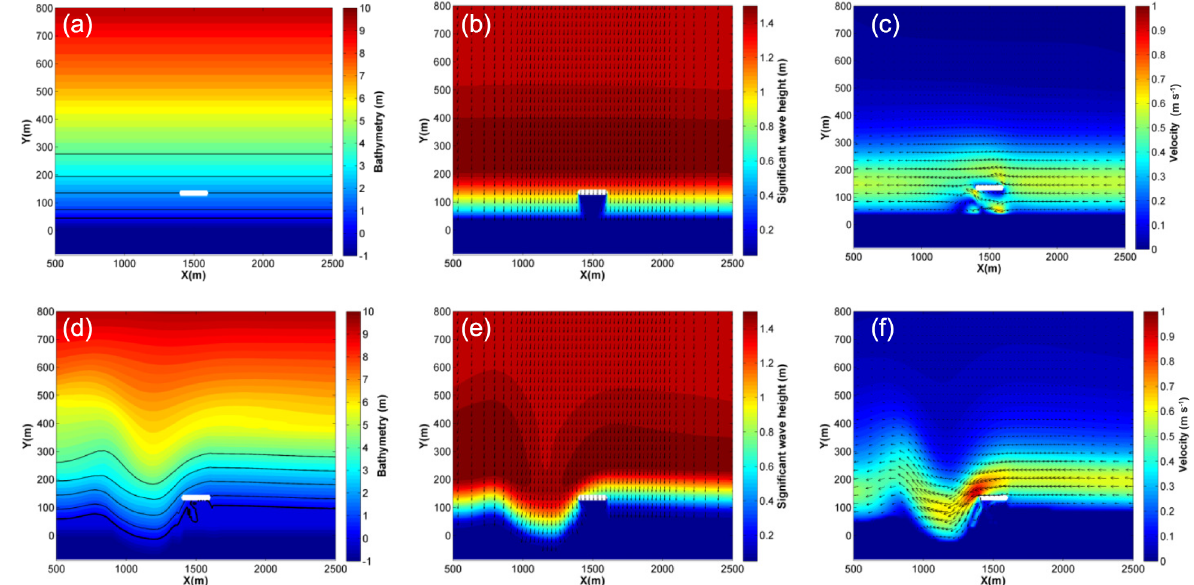
Figure 5. Model results for the breakwater’s length-to-distance ratio of 2.0. Bathymetry (a, d) , waves (b, e) , and currents (c, f) for the initial condition (a, b, c) and near equilibrium (d, e, f) after 18 years. The thicker isoline in the bathymetry represents the shoreline, whereas the others represent the 1, 2, 3, and 4m